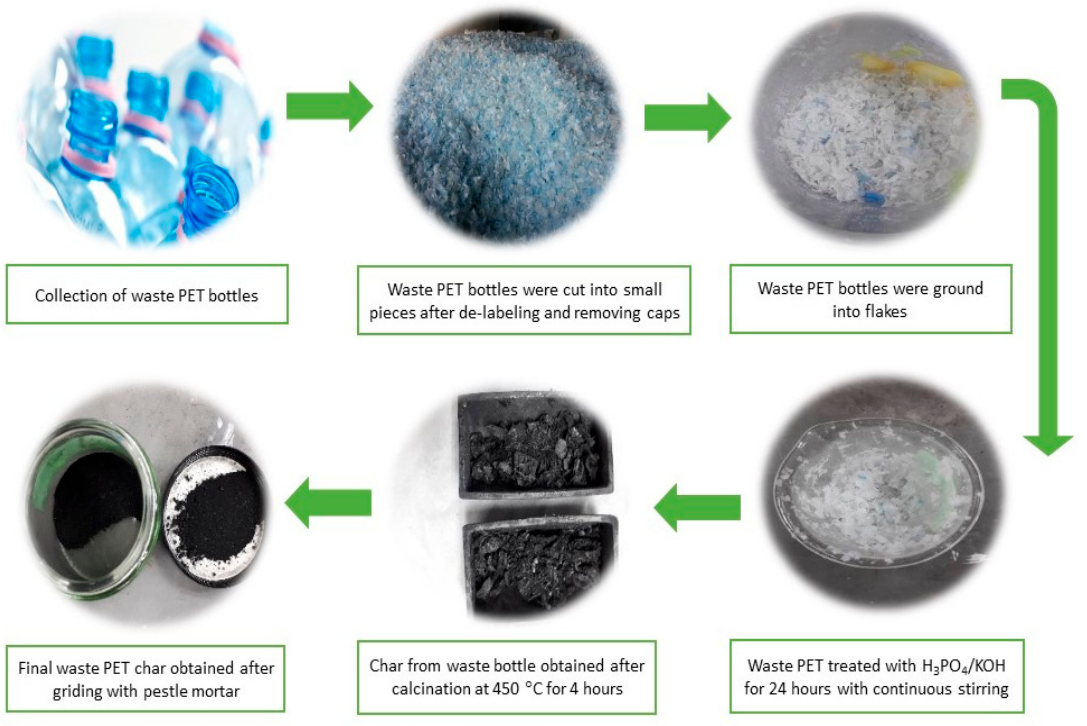
Figure 1. Synthesis of activated char from waste drinking bottles.